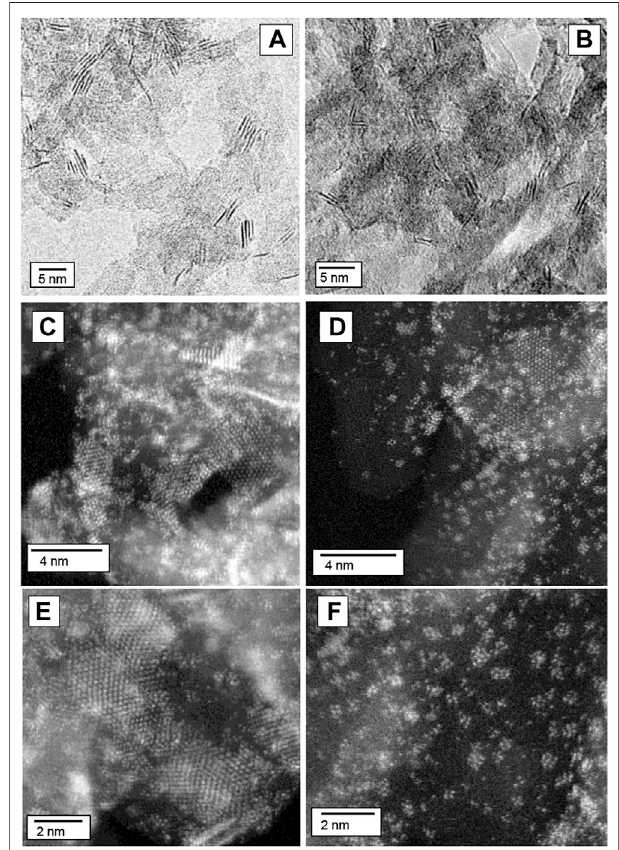
FIGURE6| HR-TEMimagesofWS 2 particlesofW(CA/W (cid:1) 0)/Al 2 O 3 and W(CA/W (cid:1) 2)/Al 2 O 3 (A,B) and HR STEM-HAADF images of W(CA/W (cid:1) 0)/ Al 2 O 3 (C,E) and W(CA/M (cid:1) 2)/Al 2 O 3 (D,F) .